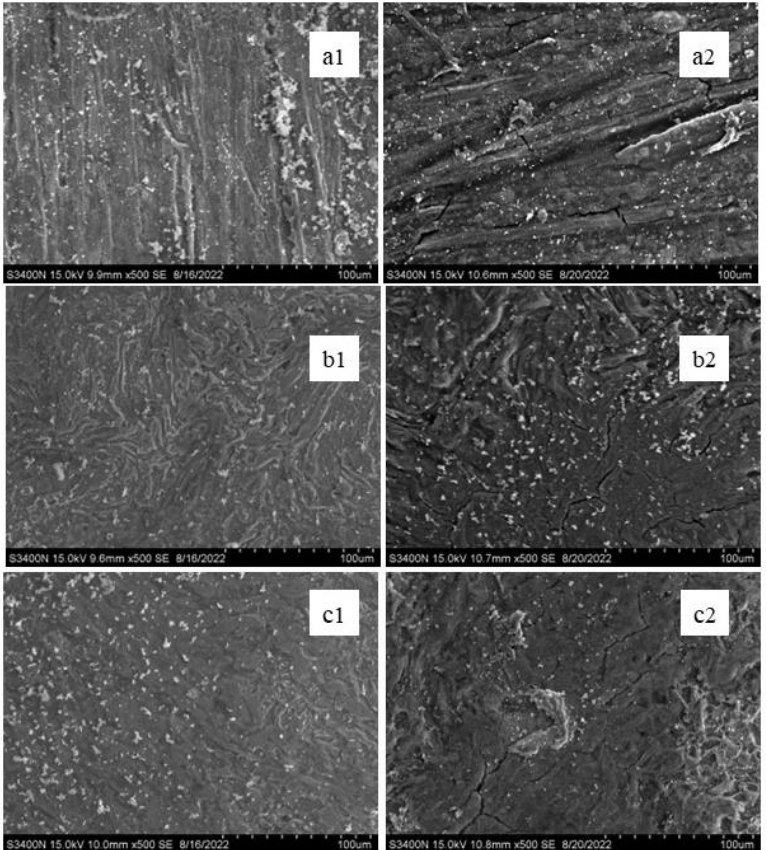
Figure 13. SEM macro-morphology characteristics of Q345B steel in 3.5 wt.% NaCl solution for 3 days: ( a1 ) un-USPed; ( b1 ) 200 s-1040 W-11 mm; ( c1 ) 200 s-2080 W-11 mm; for 7 days: ( a2 ) un-USPed; ( b2 ) 200 s-1040 W-11 mm; ( c2 ) 200 s-2080 W-11